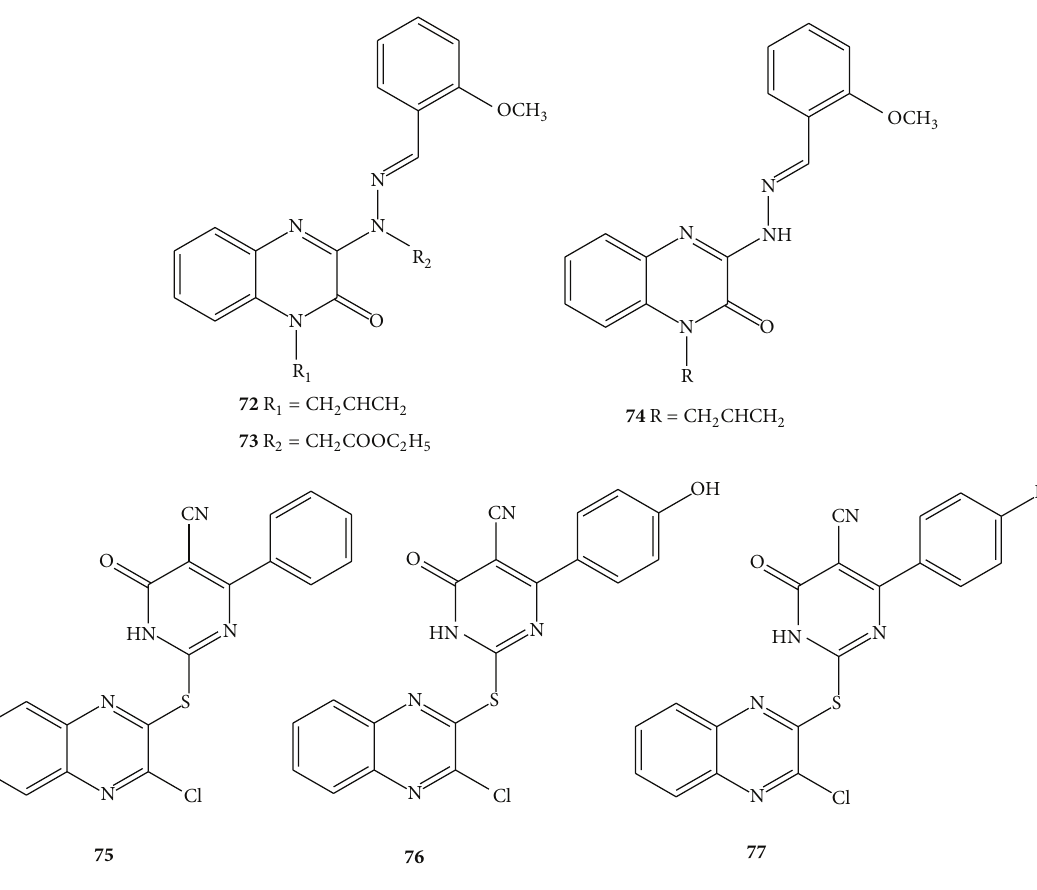
Figure 29: Chemical structure of compound 72 – 77 .